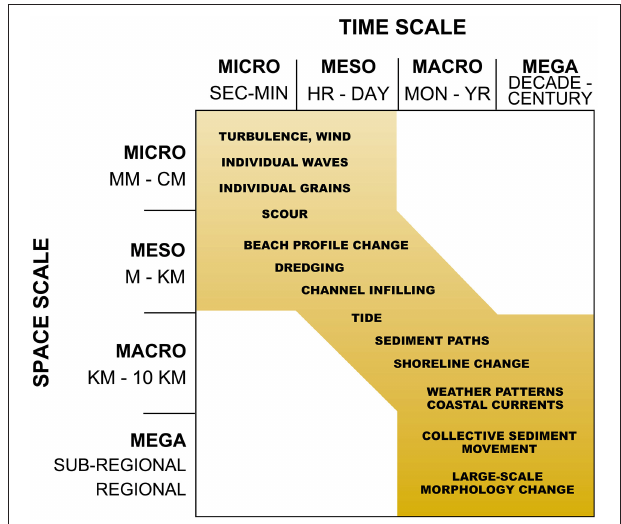
FIGURE 1 | Compatible temporal and spatial scales for sediment transport and beach morphology. White spaces indicate combined space-time scales considered to be incompatible, or unfeasible (redrawn from Larson and Kraus, 1995, with permission from Elsevier). There are various similar diagrams of this type in the